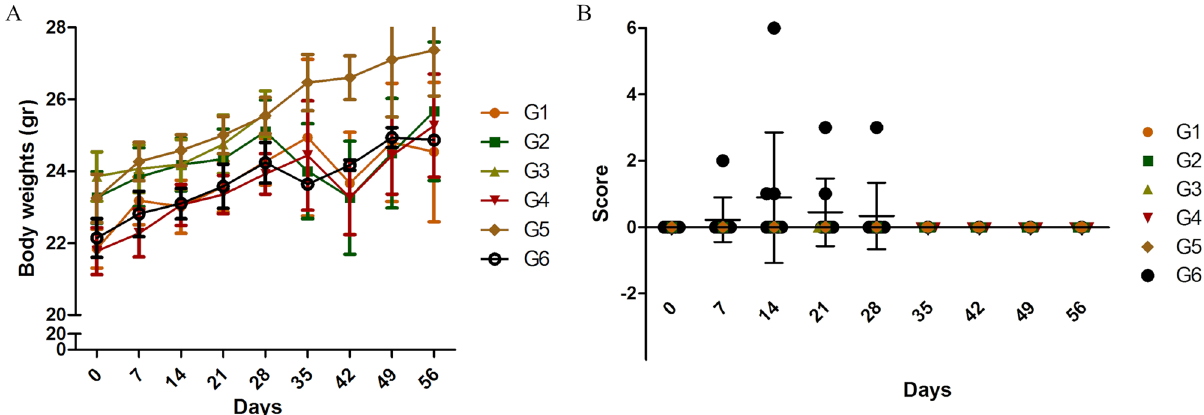
Figure 2. Body weights and general deficit. ( A ) Body weights determined in all study groups. ( B ) General deficit calculated in all study groups. The data is presented as the mean ± SEM of all mice in each